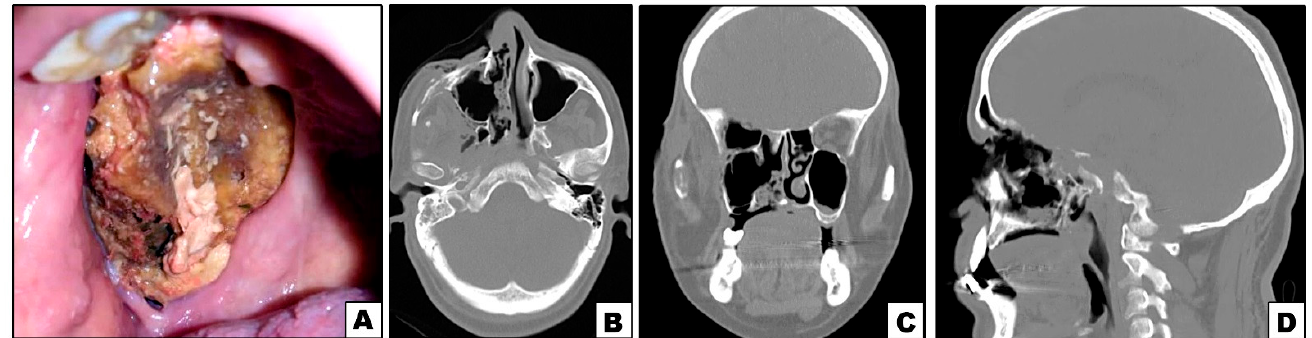
Figure 3. Case#5: ( A ) Exposed necrotic palatal and alveolar bone on right side. ( B – D ) Axial, coronal and sagittal CT showing bone destruction involving right maxilla and orbit.